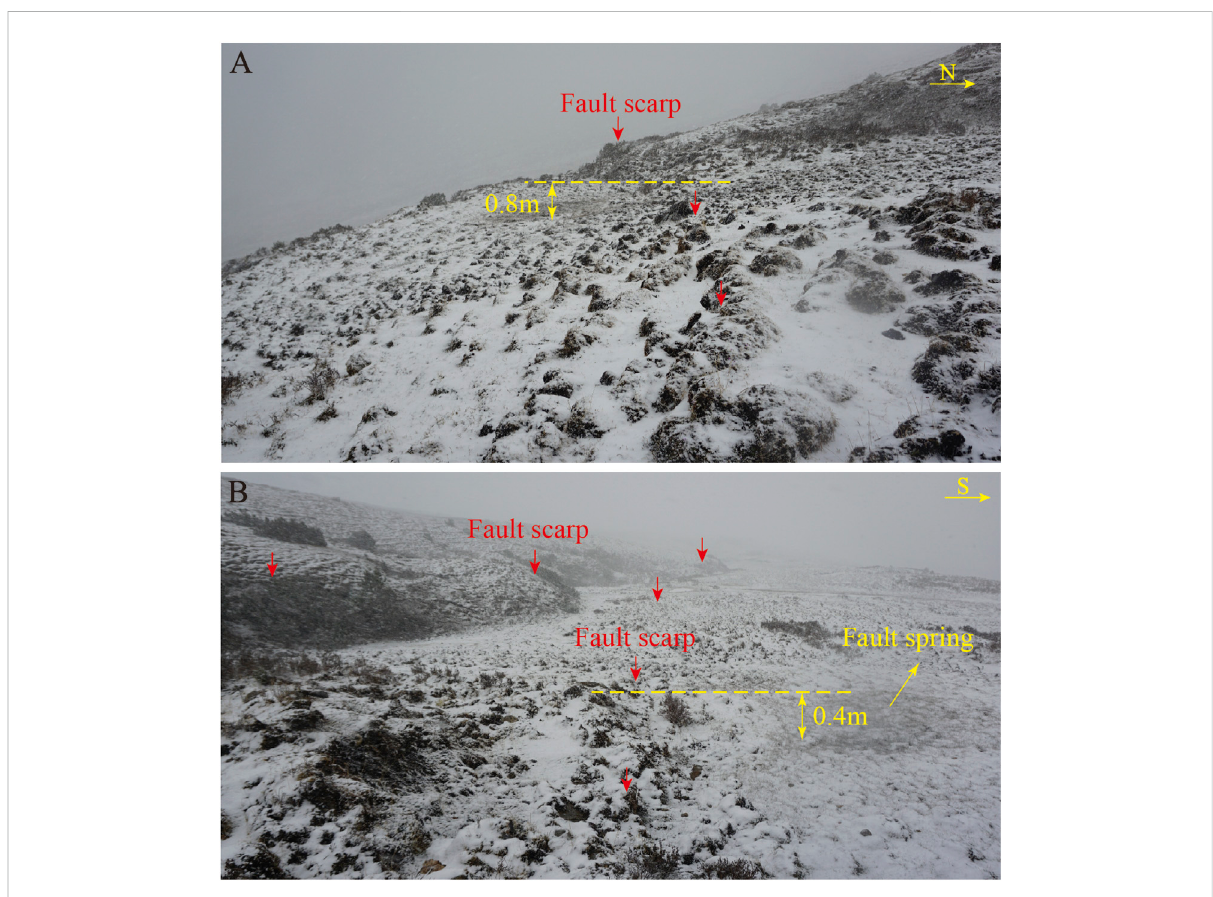
FIGURE 6 Track of the seismic surface rupture near the village of Sedi, close to Babang. (A) Seismic scarp developed on the alluvial fan (E98.78315 ° , N31.67171 ° ), and (B) fault and seismic scarp developed on the alluvial fan, with a fault spring developed under the scarp (E98.78173 ° , N31.67198 °